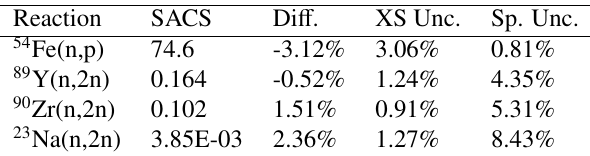
Figure 2. Irradiation of the activation foils using 252 Cf source.